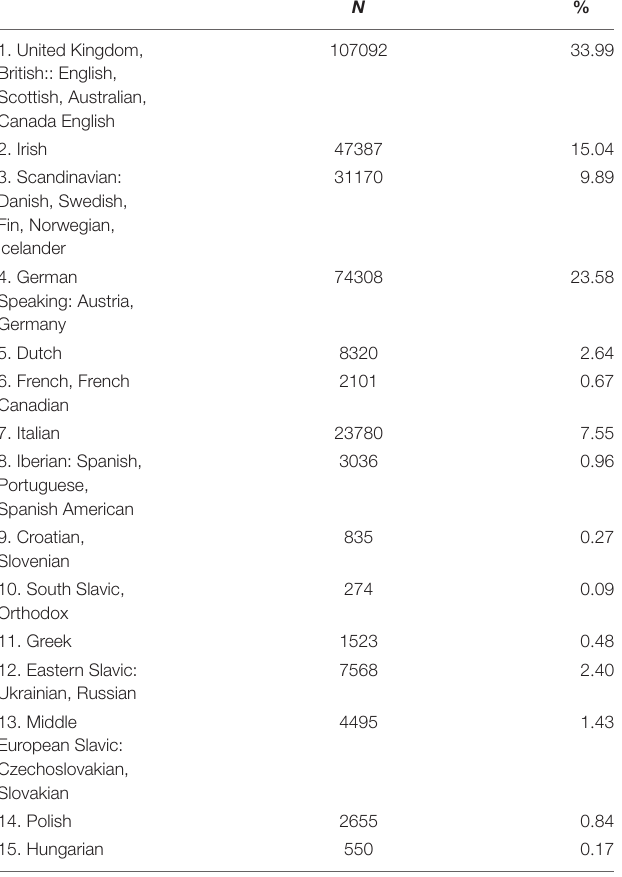
TABLE 2 | Ancestry moderately clustered.